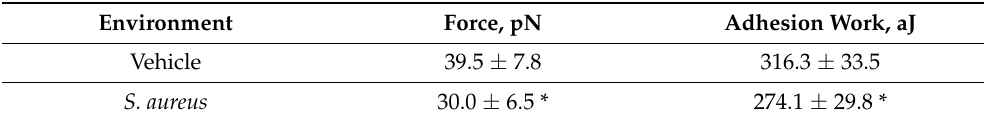
Figure 4. The force ( A ) and work ( B ) of adhesion between the receptors of neutrophils of different donors and ligands of EA.hy926 cell line endotheliocytes show suppression of interaction under opsonized S. aureus 2879 M condition. Mean ± SD are shown. A–F show different donors of neutro- phils. There were at least 5 experiments containing no less than 4 technical replicates for each donor both control and experiment (minimum of 20 FS curves for each experiment were analyzed). * Sig- nificant differences between control and experiment ( p < 0.05). Table 2. The total values of the force and work of adhesion between endothelial cells and neutrophil granulocytes under the influence of opsonized S. aureus 2879 M. The table shows the data of 21 force curves for each control and experiment for a series of 6 experiments (cells from different donors were used).